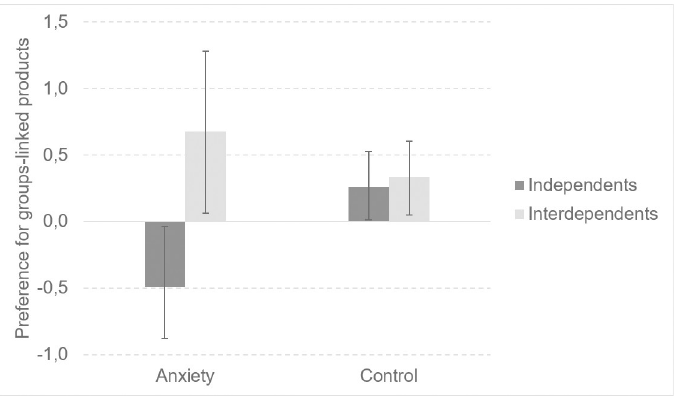
Fig 2. The effects of anxiety and self-construal on the need for uniqueness. Error bars represent standard errors estimated using the bootstrap method (95%).